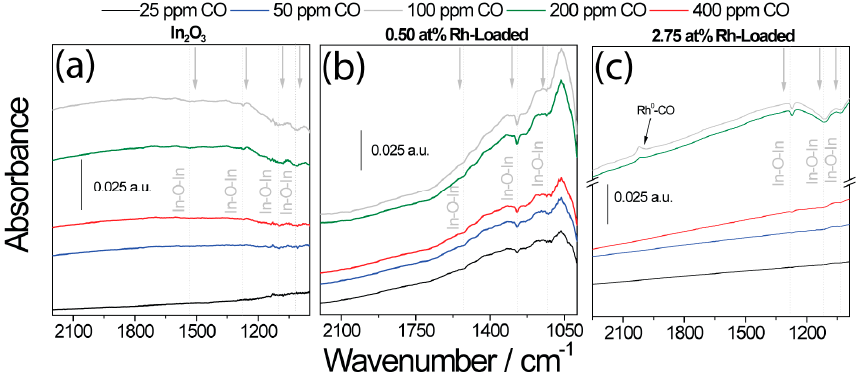
Figure 9. DRIFT spectra taken during exposure to different CO concentrations in low-oxygen (50 ppm O 2 ) backgrounds for ( a ) unloaded In 2 O 3 sample, ( b ) 0.50 at.% Rh 2 O 3 loaded In 2 O 3 , and ( c ) 2.75 at.% Rh 2 O 3 loaded In 2 O 3 .